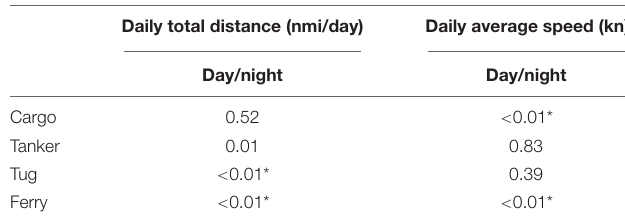
TABLE 3 | Mood’s median test results ( p -values) comparing daily total distance (nmi/day) and daily average speed (kn) across